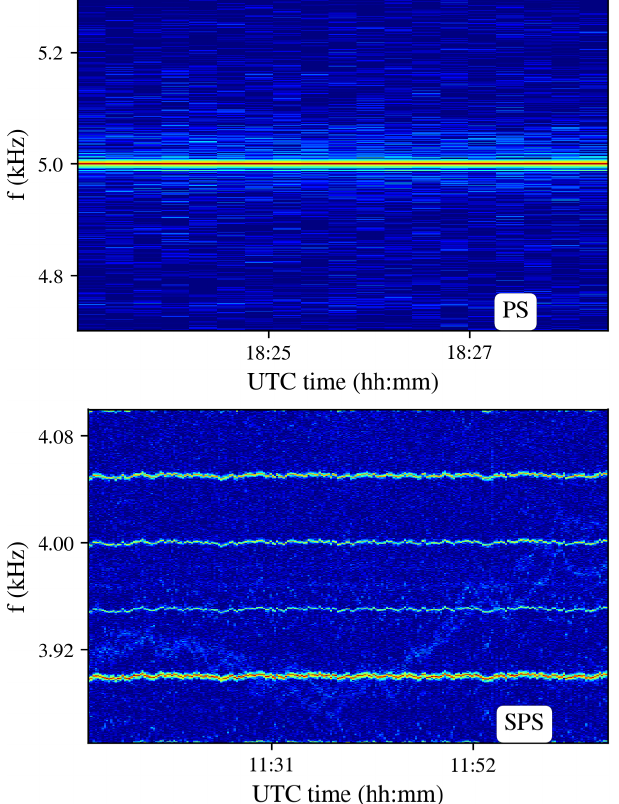
FIG. 7. The spectrum of the B-Train in PS (top) and SPS (bottom). The strong component at 5 kHz in the PS spectrum is one of the switching frequencies of the switch-mode power supply. The SPS spectrum illustrates the signature of a SCR power supply, which is characterized by a series of 50 Hz harmonics with a similar frequency evolution induced by the mains.